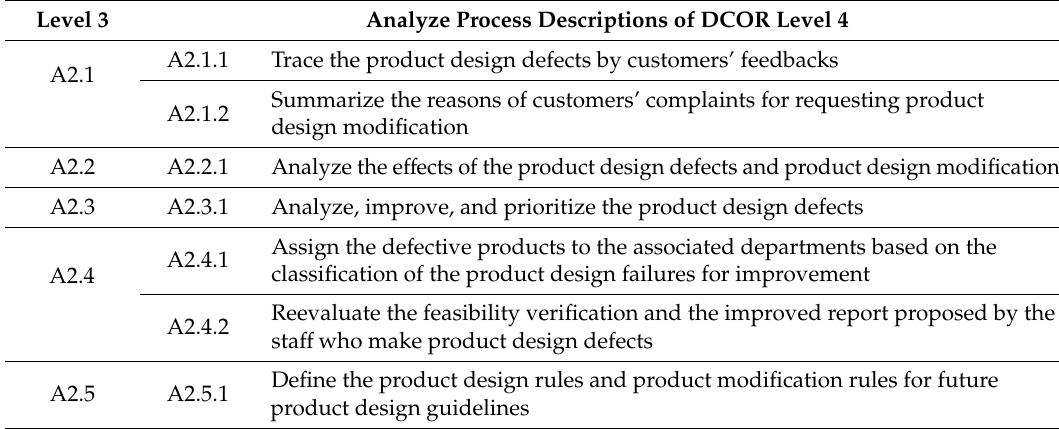
Table 5. Analyze process of DCOR Level